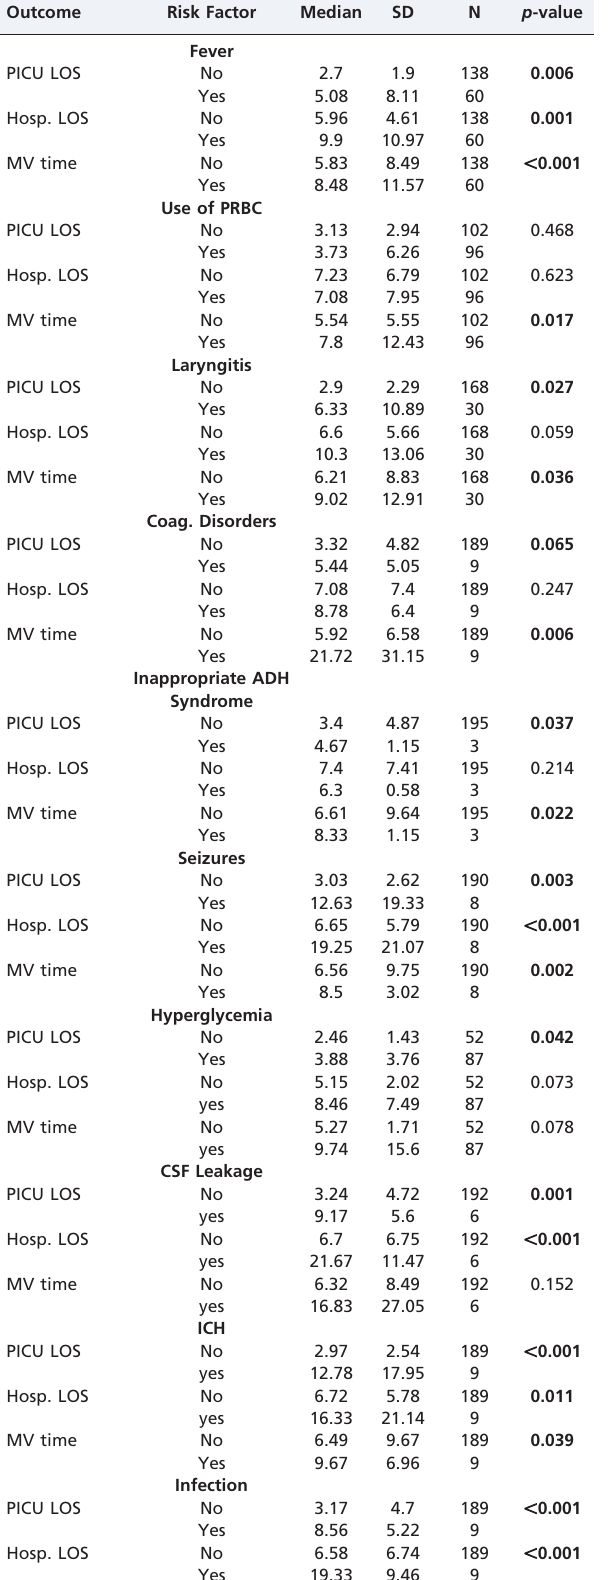
Table 2 - Results of univariate analysis. Outcome Risk Factor Median SD N p -value Fever PICU LOS